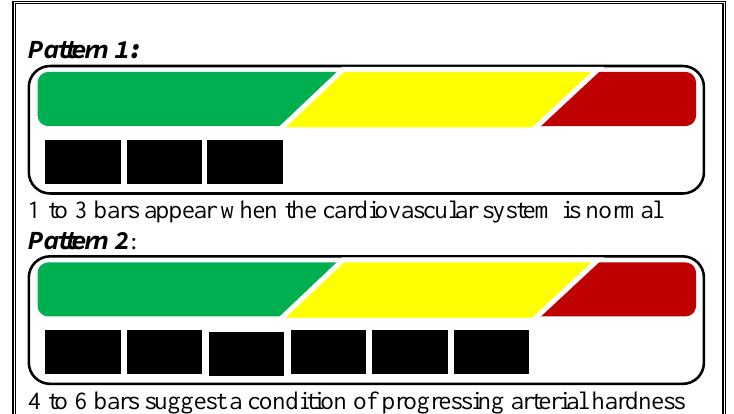
Figure 1: H-Value measurement result on the LCD Display of ASI measuring